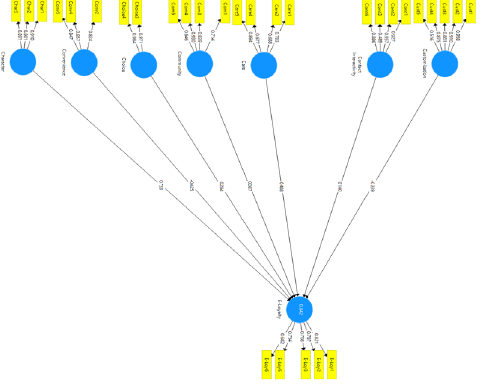
Fig. 3. Research conceptual